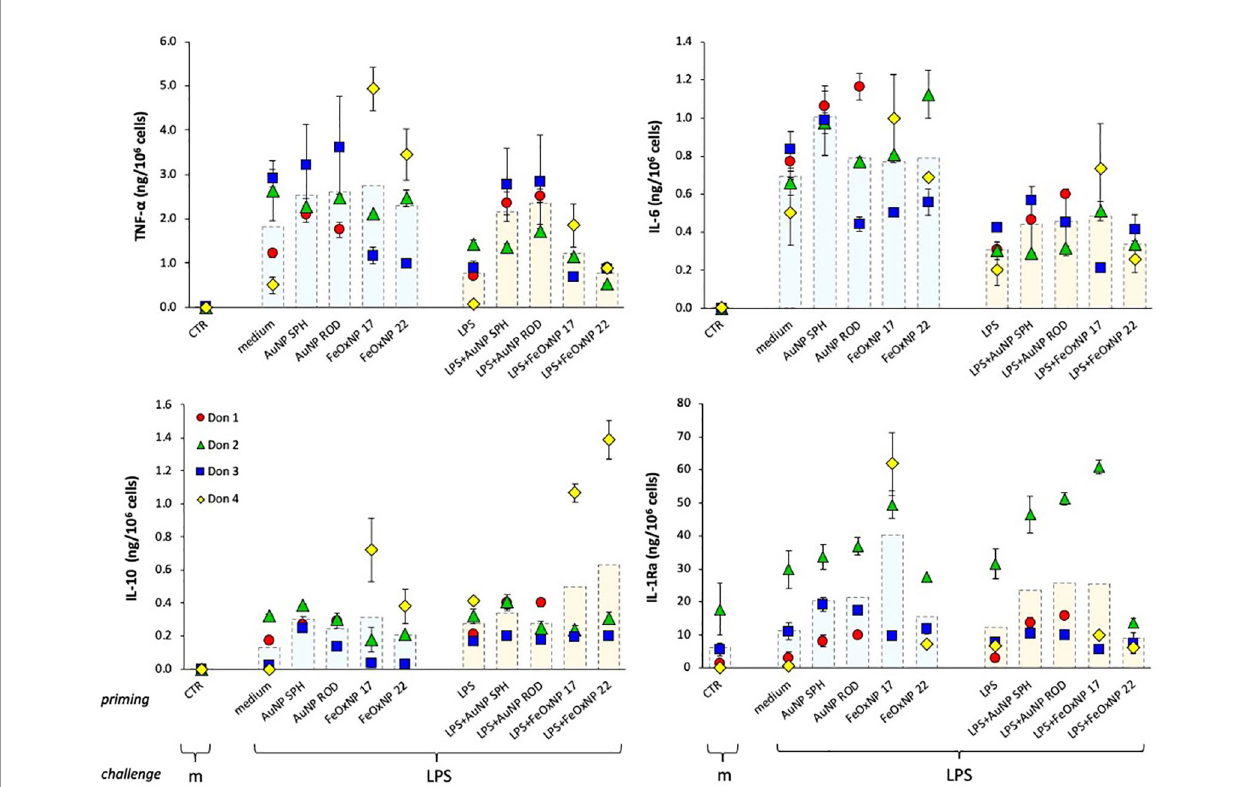
FIGURE 3 | Innate immune memory response of human monocytes primed with NP alone or together with LPS. Human monocytes isolated from blood of four individual donors (red, green, blue, and yellow symbols) were cultured for 24 h in culture medium alone or containing serum-precoated NP: 5.7 µg/ml AuNP SPH, 1.4 µg/ml AuNP ROD, 2 µg/ml FeOxNP 17 and 2.7 µg/ml FeOxNP 22 alone (light blue columns) or together with 1 ng/ml LPS (orange columns) (line priming in abscissa). Cells were then washed and rested for 6 days in the absence of stimuli, then challenged for 24 h in fresh medium alone or containing 5 ng/mL LPS (m and LPS in the abscissa line challenge ). The production of TNF a (upper left), IL-6 (upper right), IL-10 (lower left) and IL-1Ra (lower right) was measured in the 24 h supernatants by ELISA. Data are presented as individual donors ’ values (coloured symbols) ± SD and as mean of the individual values (dotted columns). The basal response of control cells (CTR), i.e. , primed or unprimed cells rested for 6 days and then exposed for 24 h to medium alone, is shown at the extreme left in each panel (empty